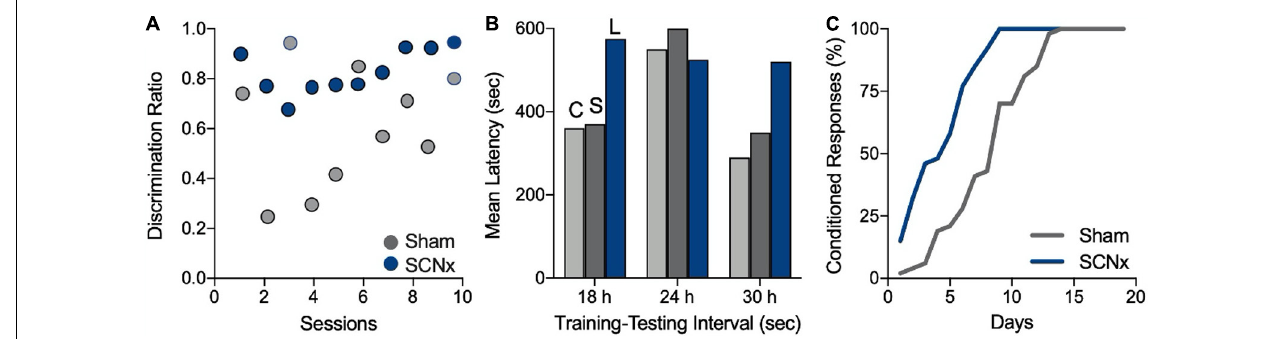
FIGURE 2 | SCN lesions appear to improve memory. (A) Rats were trained in a discrimination task that required them to obtain a food reward from one feeder in the morning and another feeder in the afternoon. Higher discrimination scores indicate better memory retention. Circles represent mean scores for each group by session. SCNx rats (blue) appeared to acquire the discrimination in fewer sessions than did sham-operated rats (gray). Figure modified from Mistlberger et al. (1996). (B) Rats in a passive-avoidance task learned to avoid entering a dark box where they previously received a foot shock. Longer latencies to reenter the dark box signify better memory of the shock. SCN lesions resulted in longer latencies and appeared to improve memory of the shock at 18 or 30 h after training (C, control; S, sham-lesioned; and L, SCN-lesioned). Figure modified from Stephan and Kovacevic (1978). (C) Rats were trained to replace a conditioned reflex to sound with one conditioned to a fixed time interval of 20 s. Training sessions consisted of 20 trials/day over 1 month. The authors statistical analysis showed that SCNx rats acquired the response significantly faster than sham-operated animals. Figure modified from Vodolazhskaya et al. (2001). All figures redrawn from published data and are for illustration purposes